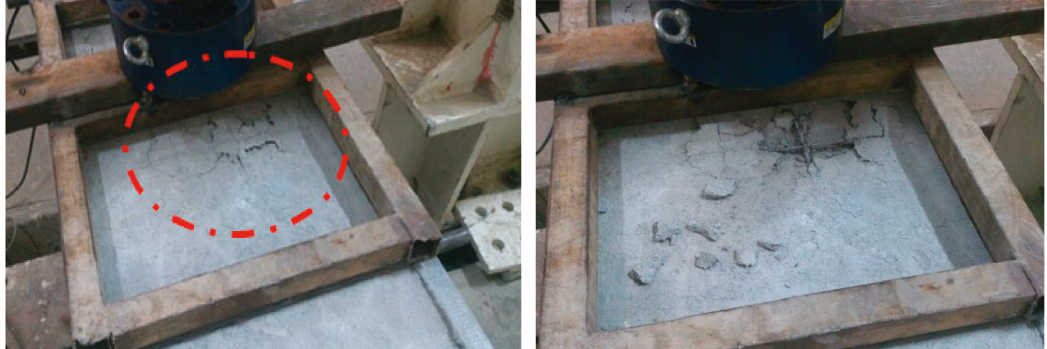
Figure 14: The cold-rolled galvanized sheets buckling below and between loading bars in the final